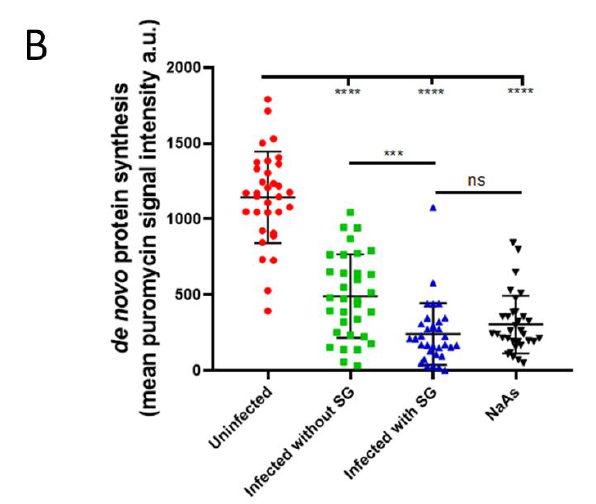
Figure 8. SG formation in IBV infected cells is correlated with increased translational shut-o ff . ( A ) Vero cells were mock infected or infected with IBV. At 23 hpi, positive control cells were treated with sodium arsenite (NaAs), to induce inhibition of translation. At 24 hpi, cells were treated with puromycin followed by emetine. Cells were then fixed, and nascent polypeptides labelled with puromycin were detected using an anti-puromycin antibody (red), stress granules labelled with anti-G3BP1 (green) and IBV infected cells labelled with an anti-IBV antibody (cyan). Nuclei were stained with DAPI (blue). Scale bar indicates 20 µ m. ( B ) Representative scatterplot of de novo protein synthesis from ( A ), measured by fluorescence intensity of the puromycin signal analyzed in 80 cells. Data presented is representative of three independent replicates. Asterisks indicate statistical significance, as measured by one-way ANOVA, *** p = 0.0004; **** p < 0.0001.